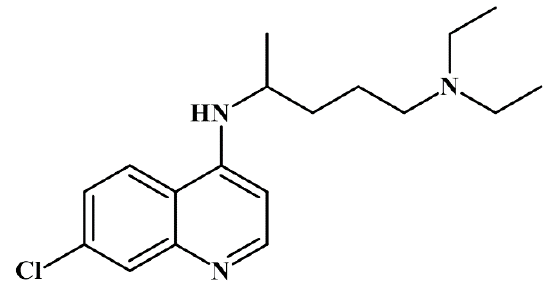
Figure 1. Molecular structure of chloroquine.